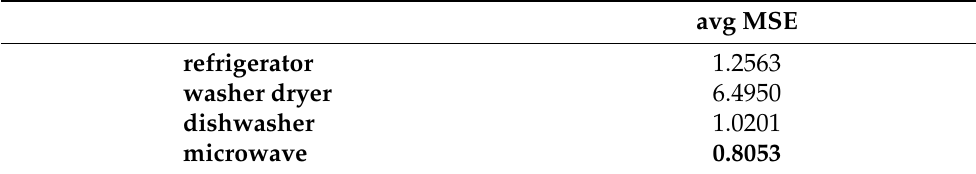
Table 4. Comparison of MSE in the amplitude